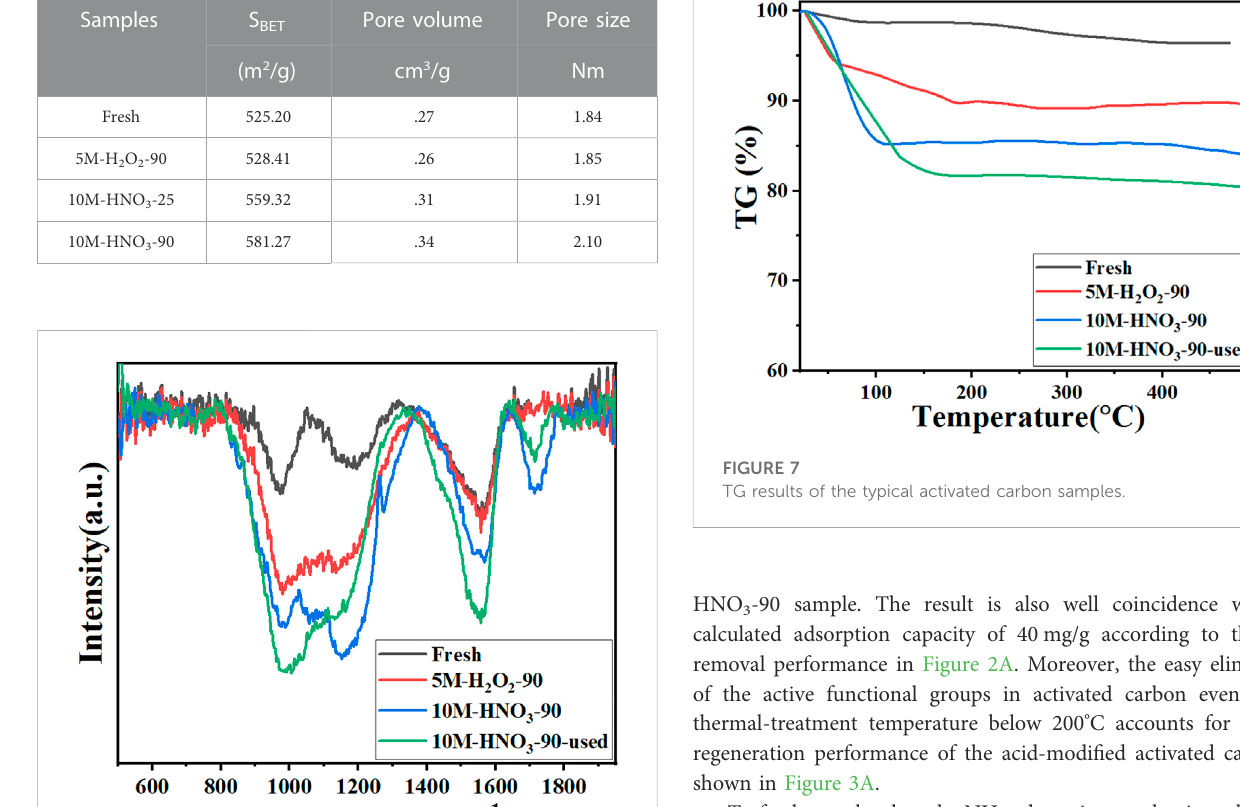
FIGURE 6 FTIR results of the typical activated carbon samples.